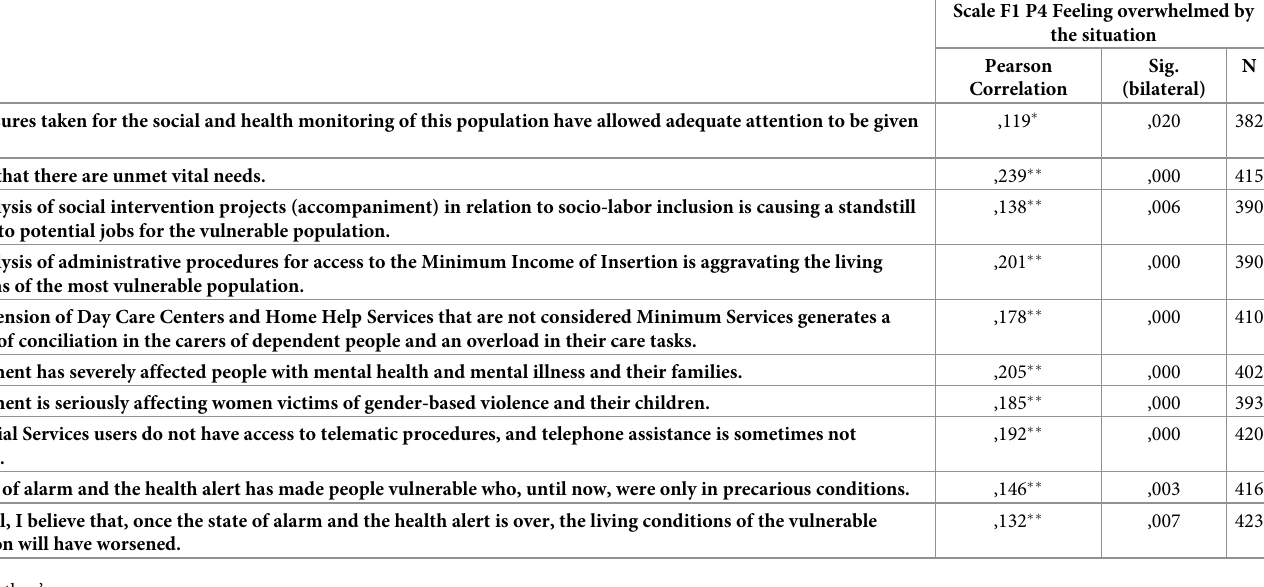
Table 6. Correlations between feeling overwhelmed and the measures developed to attend to the vulnerable